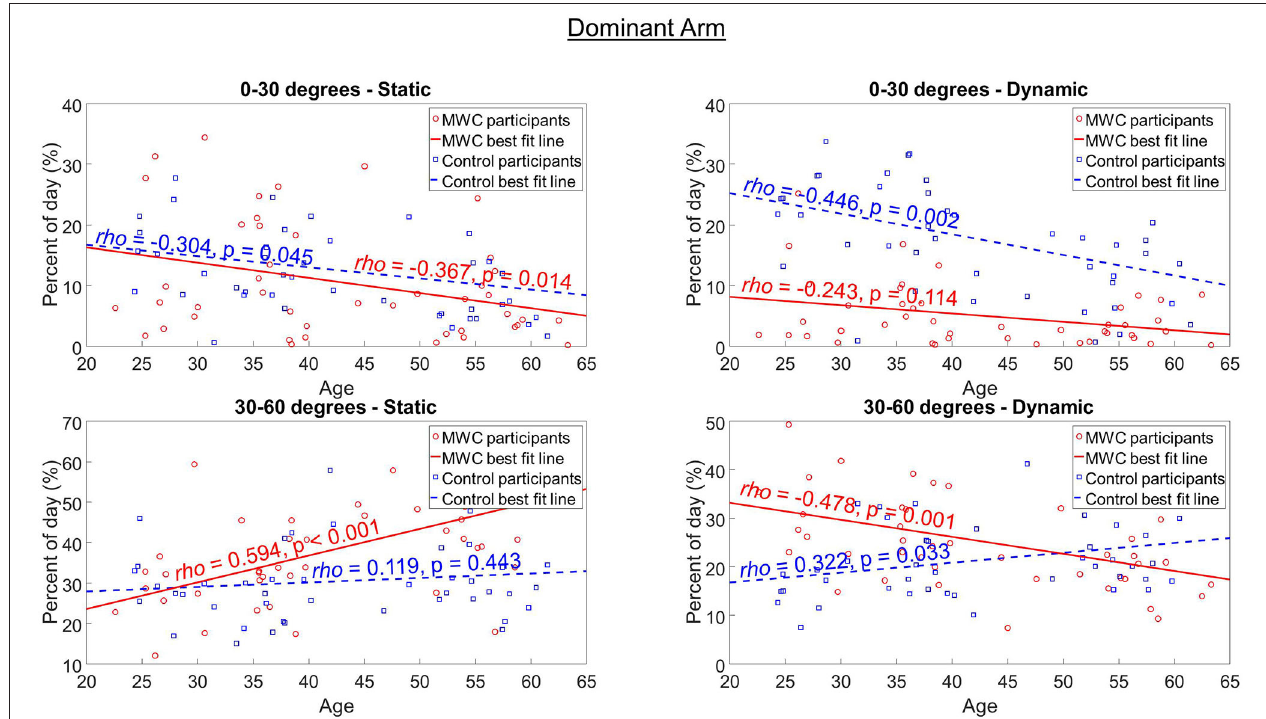
FIGURE 3 | The association between age and the percentage of the day static and dynamic in 0–30 ◦ and 30–60 ◦ of humeral elevation on the dominant arm for MWC (red circles and red solid line) and control (blue squares and blue dashed line) cohorts. The Spearman’s Correlation rho ( ρ ) denotes the strength of the association and the p -value shows the significance. Figures of the additional humeral elevation ranges for the dominant and non-dominant arms can be found in the Supplementary Material sections C and D,